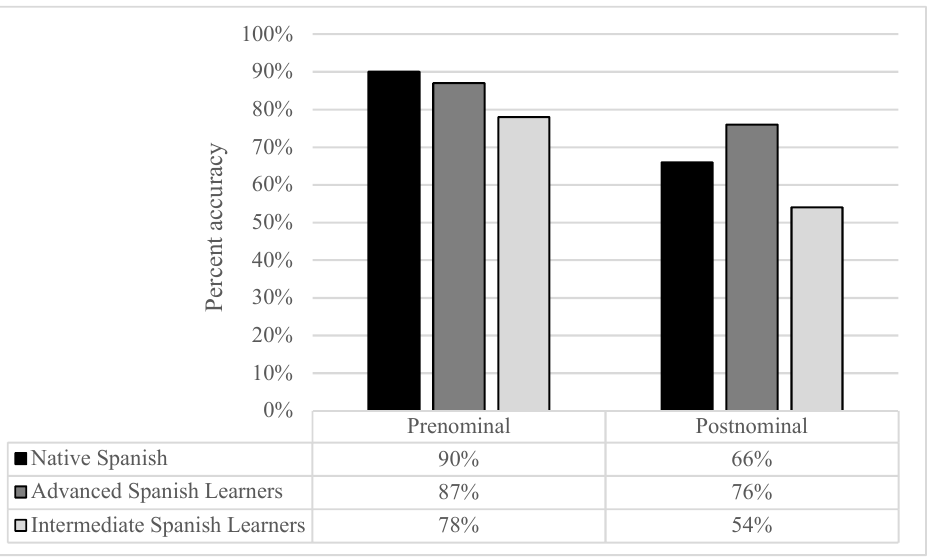
Figure 2. SIT group results.